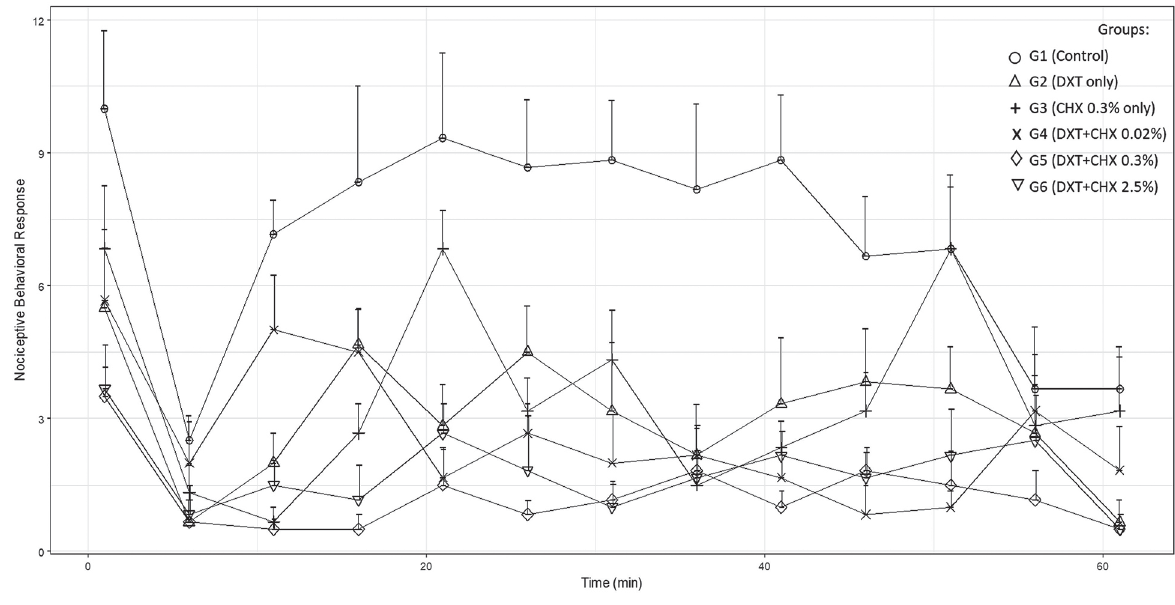
FIGURE 1 - Time course of the nociceptive behavioral response of the experimental groups (n=6 rats each group). Each symbol represents the mean with S.E.M., over the 60 min post-injection observation period.